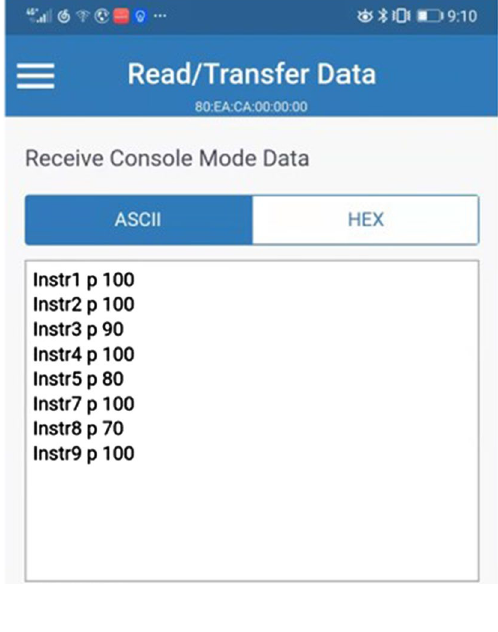
Table 3 Experimental results for malware detection on 6 benchmarks in 3 scenarios on 3 boards inside RASC for real- time verification. P i , F i , and S